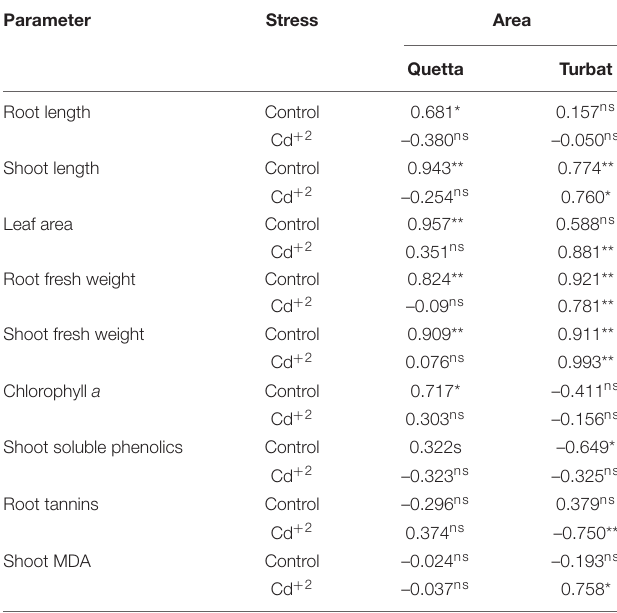
TABLE 2 | Correlation of changes in various morpho-physiological attributes of milk thistle with shoot and root dry weights grown at Quetta and Turbat under cadmium stress ( n =